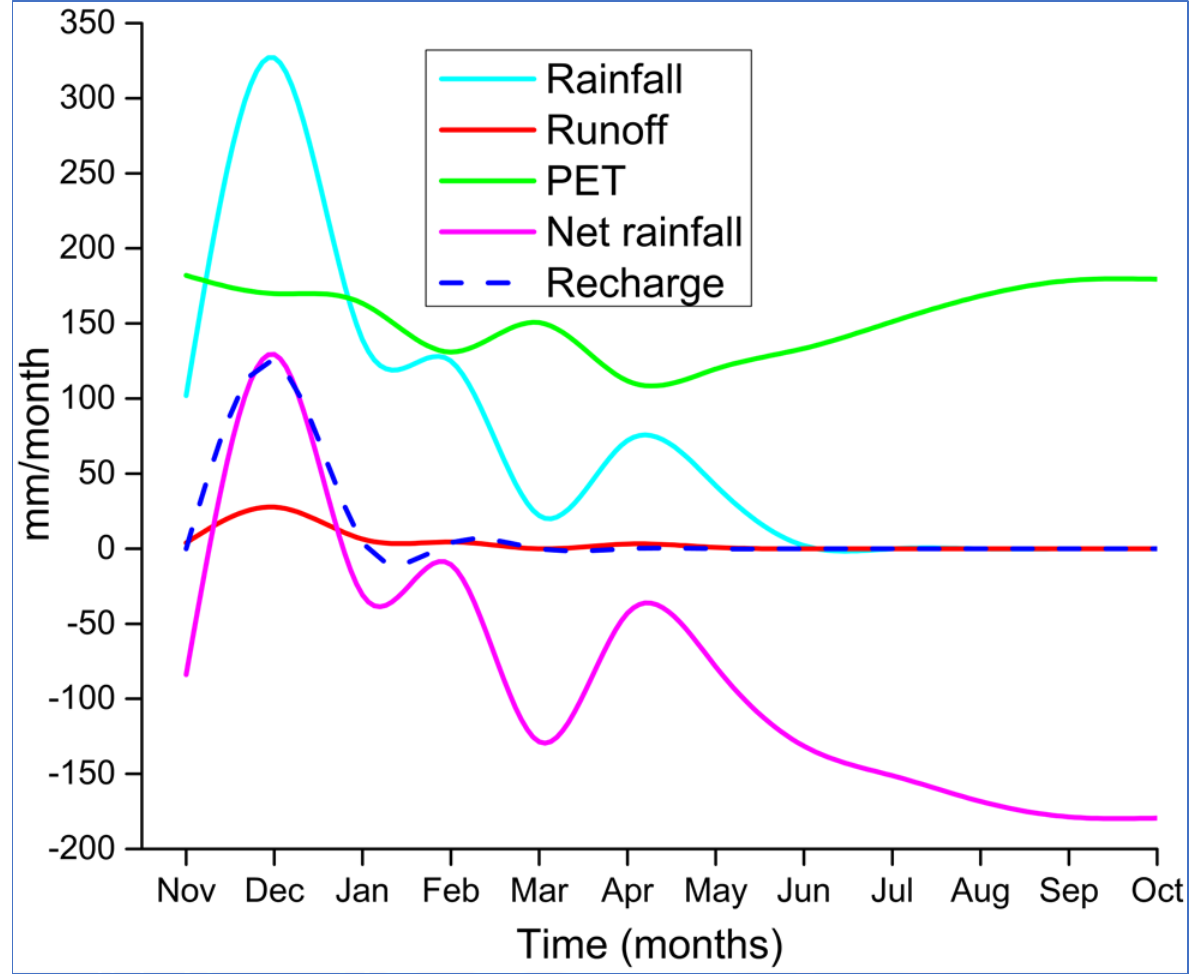
Figure 8. A 1996/1997 hydrological year graph of rainfall, runoff, PET, net rainfall, and aridity index in the Singida aquifer.